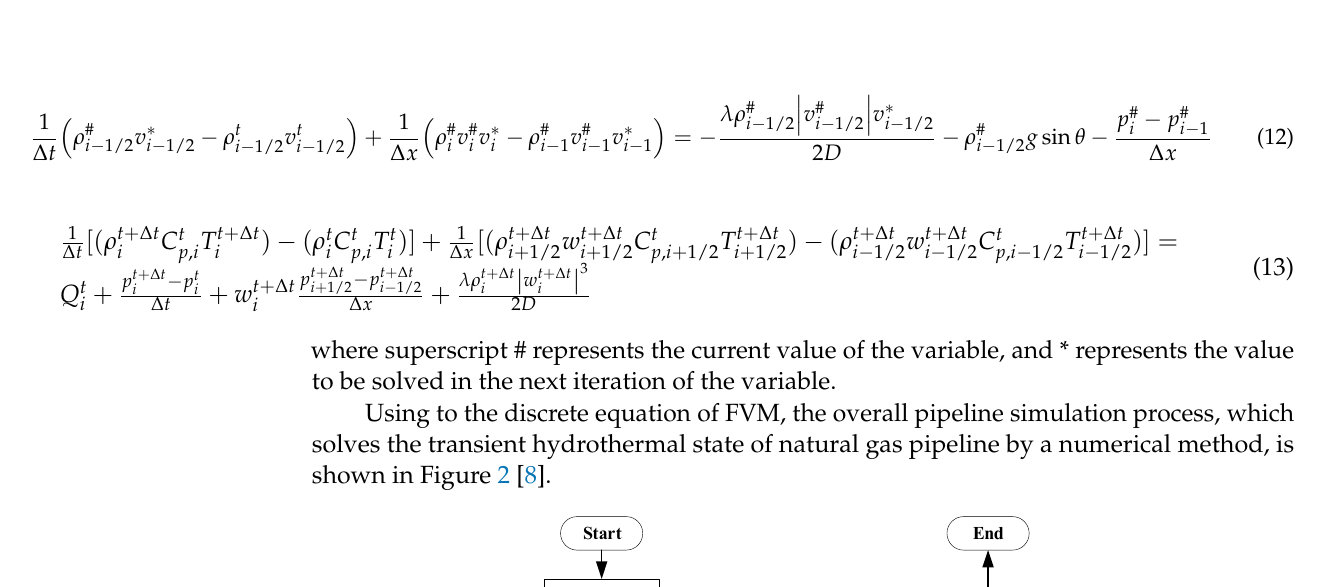
Mass control volume Figure 1. Schematic diagram of pipe grid division.